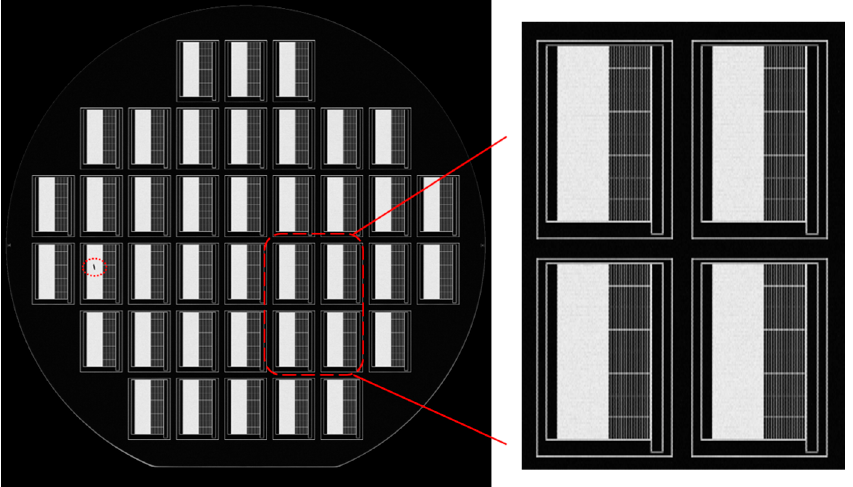
Figure 6. Scanning acoustic microscopy (SAM) to inspect bonding quality. A particle appeared as a black dot on the left side, and a zoomed-in SAM image of four